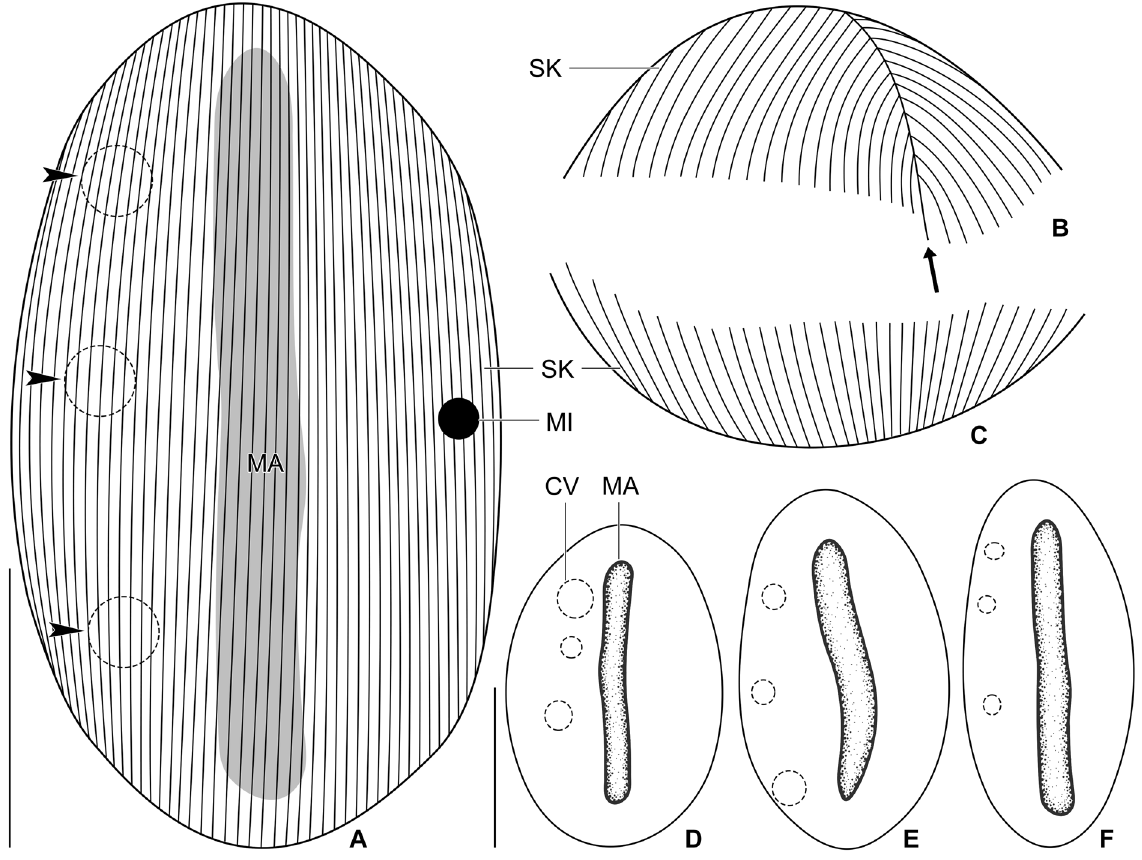
Fig. 10. Anoplophrya vulgaris de Puytorac, 1954, Slovak specimens in vivo . A . Semi-schematic diagram of the ventral side, showing the nuclear apparatus, the arrangement of contractile vacuoles (arrowheads) and the somatic ciliary pattern. B–C . Details of the anterior body pole and the posterior body region, showing the course of the somatic kineties. Arrow denotes the apical suture. D‒F . Variability of body shape and size as well as of the contractile vacuole and nuclear apparatus. Drawn to scale. Scale bars: 50